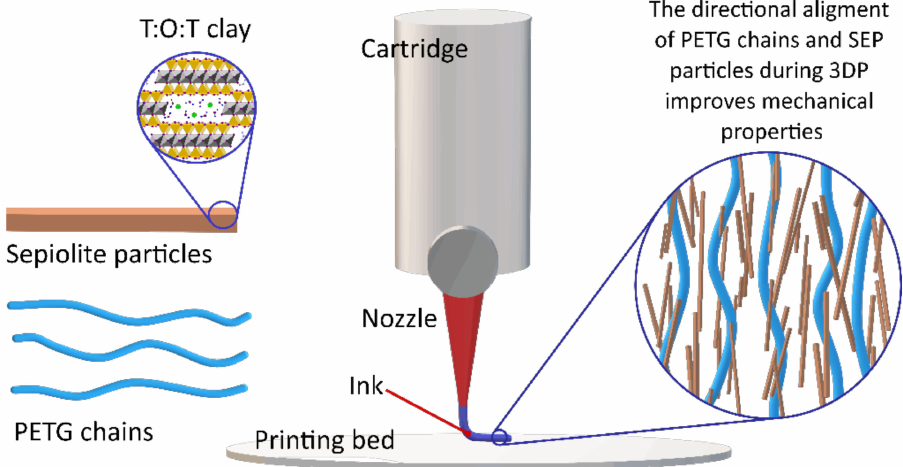
Figure 6. Schematic representation of the directional alignment of SEP particles with PETG chains during extrusion-based 3DP, according to the description and hypotheses reported in